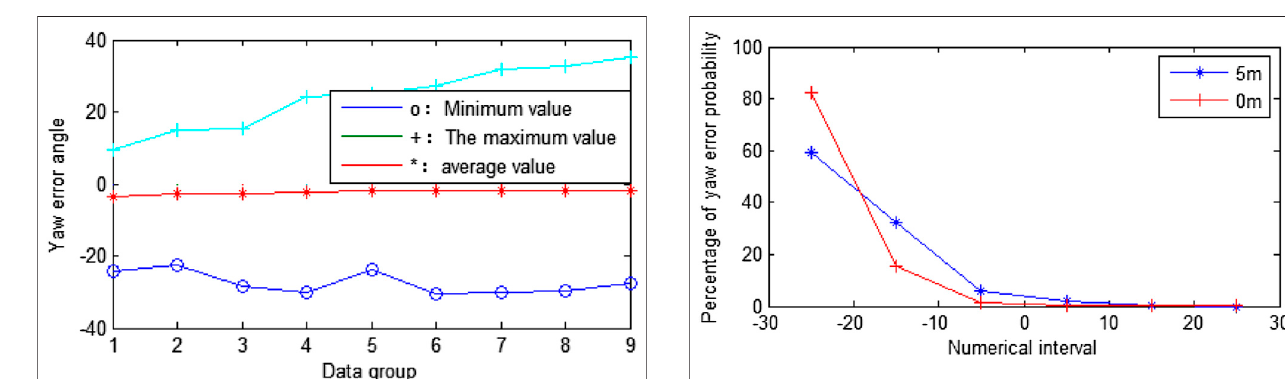
Above the cabin (%) instrument 5 m (%)